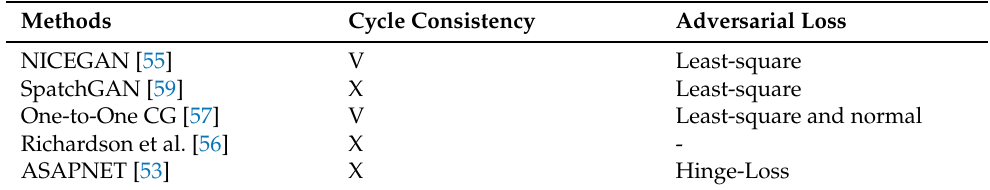
Table 4. Comparison between proposed methods in Architecture Change. In this category (Section 5), we compare papers based on if they use the cycle consistency and the type of adversarial loss. “V” and “X” means that the method use the technique in the columns is “used” and “not used” respectively. “-” denotes that authors did not mention this information.